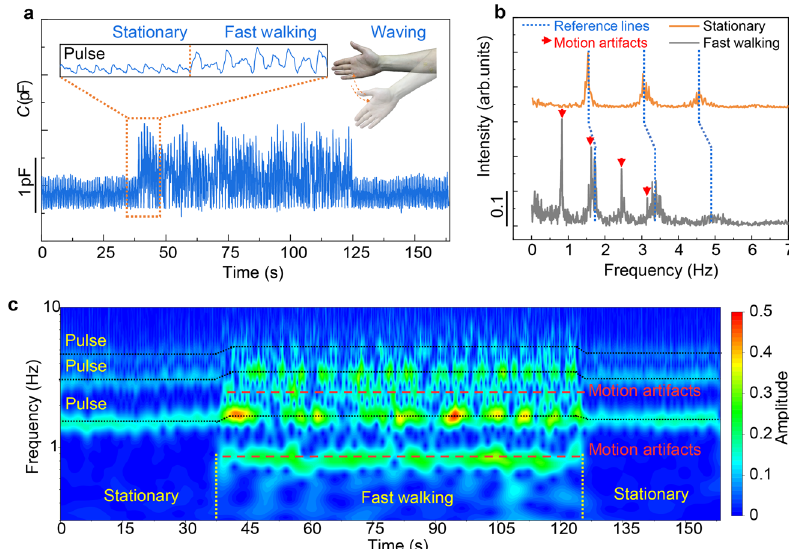
Fig. 4 Interference immunity of electrical noise. a Signal outputs during fast walking (walking frequency ~0.8 Hz), showing that sports cause limited noise amplitude. Tests were carried out with the SE attached on a thumb. Inset shows pulse signal and motion artifacts. b Frequency-domain analysis of the pulse signal with motion artifacts. c Continuous wavelet transform of the same signal in panel ( a ), revealing temporal dependence frequencies which coincide with the onset and termination of intense physical